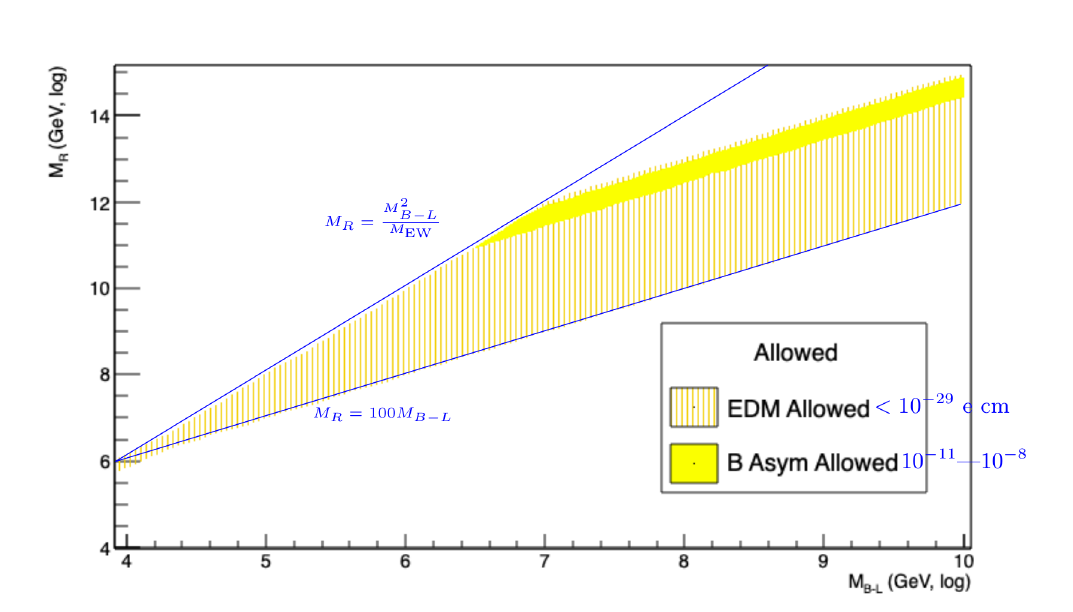
Figure 6 . The regions in the ( M B − L , M R ) -plane allowed by the experimental bounds on baryon asymmetry in yellow and electron EDM hatched green, plotted for the same parameter set as figure 1–4. The upper blue line denotes the setting M R = M 2 /M EW and the lower blue line B L M R = 100 M B − L . The baryon asymmetry allowed region is the narrow region entirely subsumed within that allowed by the EDM constraint and overlaid on the latter. The two regions run parallel at upper boundary with EDM allowed region somewhat larger. To be specific, 10 6 . 5 < M B − L < 10 10 GeV and bears out the philosophy of eq. (2.14) only towards the lowest end of the